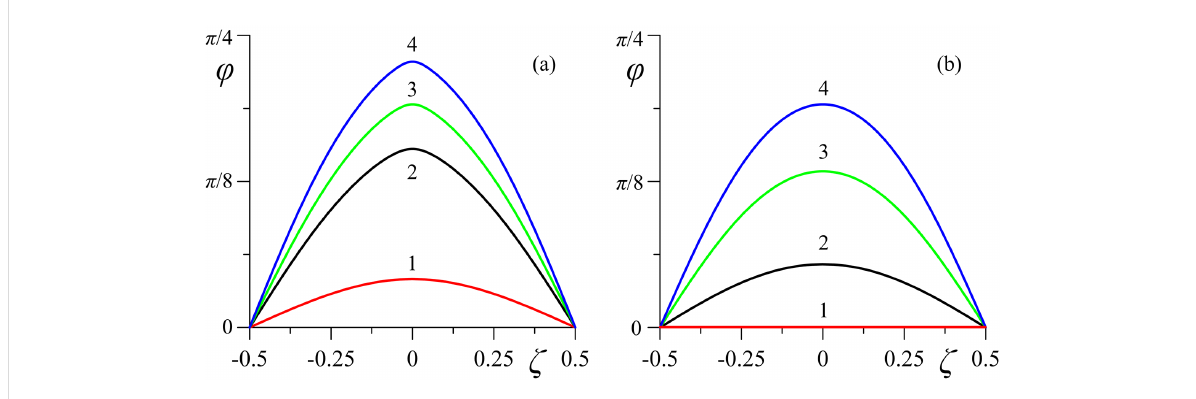
dotted lines correspond to metastable states, and the vertical segments of the straight lines show the first-order phase transi- tion. The calculations were carried out for σ = 5, γ = 0.2, k = 1.5 and various values of the segregation parameter κ . The orienta- tion phase diagram for the selected parameters is shown in Figure 2. The value of the second-order transition field h c = 2.824 from the planar phase into the angular phase was found using Equation 15, the value of the tricritical segregation parameter κ * = 0.056 was determined using Equation 19. In the limit of absolutely rigid anchoring for these parameter values, using Equation 18 and Equation 20, respectively, we obtain the Freedericksz transition field rameter corresponding to the tricritical point